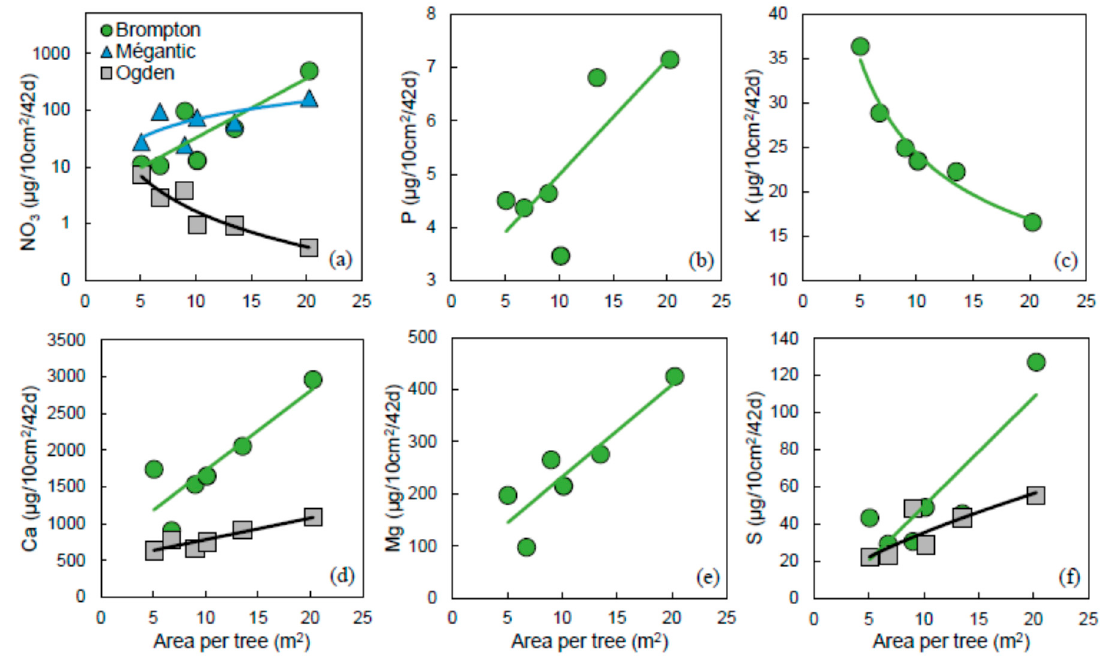
Figure 4. Site-specific relationships between the area per tree at planting and the supply rate of soil ( a ) nitrate, ( b ) phosphorus, ( c ) potassium, ( d ) calcium, ( e ) magnesium and ( f ) sulfur during the 14th growing season in hybrid poplar plantations. Only relationships with p < 0.1 are presented. Model type, fit and significance level of the relationships are the following for panel ( a ): Brompton site (exponential model, R 2 = 0.74, p < 0.05), Mégantic site (linear model, R 2 = 0.60, p = 0.07), Ogden site (linear model, R 2 = 0.88, p < 0.01); for panel ( b ): Brompton site (linear model: R 2 = 0.64, p = 0.06); for panel ( c ): Brompton site (power model, R 2 = 0.97, p < 0.001); for panel ( d ): Brompton site (linear model, R 2 = 0.76, p < 0.05), Ogden site (linear model, R 2 = 0.87, p < 0.01); for panel ( e ): Brompton site (linear model, R 2 = 0.79, p < 0.05); for panel ( f ): Brompton site (linear model, R 2 = 0.76, p < 0.05), Ogden site (linear model, R 2 = 0.71, p < 0.05). Nutrient supply rates were measured in hybrid poplar plantations during 42 days (6 August–17 September 2013).